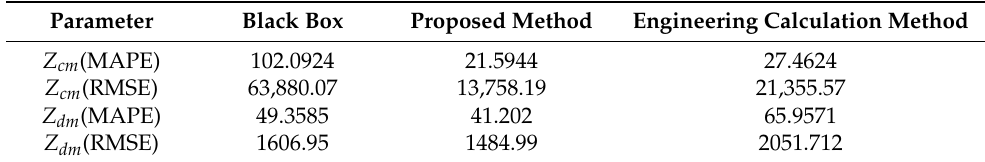
Table 2. The results of MAPE and RMSE of the three